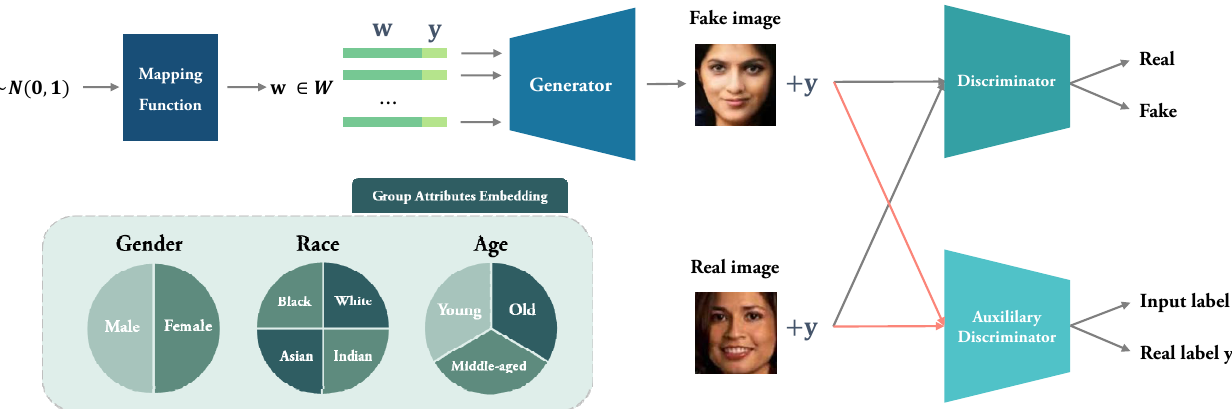
Figure 2. Our model is executed as follows. Mapping function f , the first module of our model, produces latent vectors from random noises via eight fully connected layers. We built an input vector by concatenating the latent vector with a conditional vector that designates the group attributes. Generator G , the second module of our model, produces a synthesized image from the input vector. Discriminator D 1 , our third module, discriminates whether the synthesized image is real or fake. Auxiliary discriminator D 2 , our fourth module, discriminates the group attributes of a synthesized image by classifying the